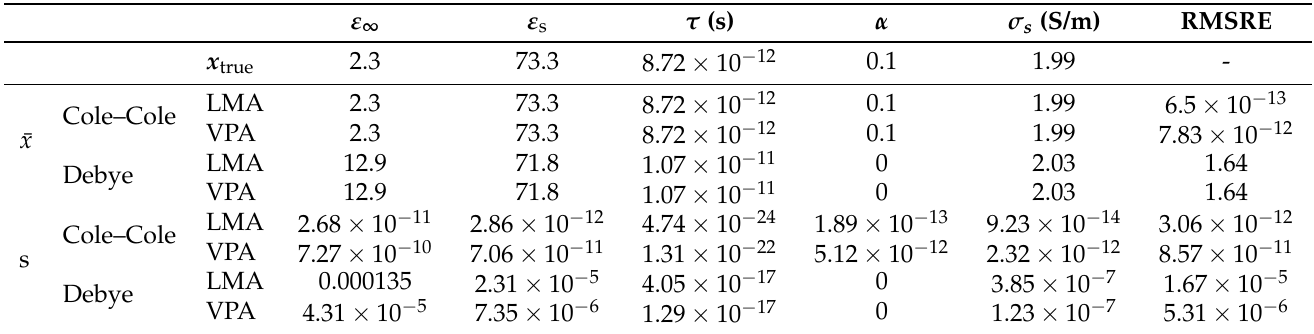
Figure 6. Real part of relative permittivity and conductivity of synthetic data (250 mg/dL glucose concentration) and Debye’s and Cole–Cole’s fitted curves. LMA ( a ) and VPA ( b ) with Set C of initial points are used. Table 1. Statistical diagnostics on fitting results. Set A of the initial points and 100 mg/dL glucose concentrations were considered.